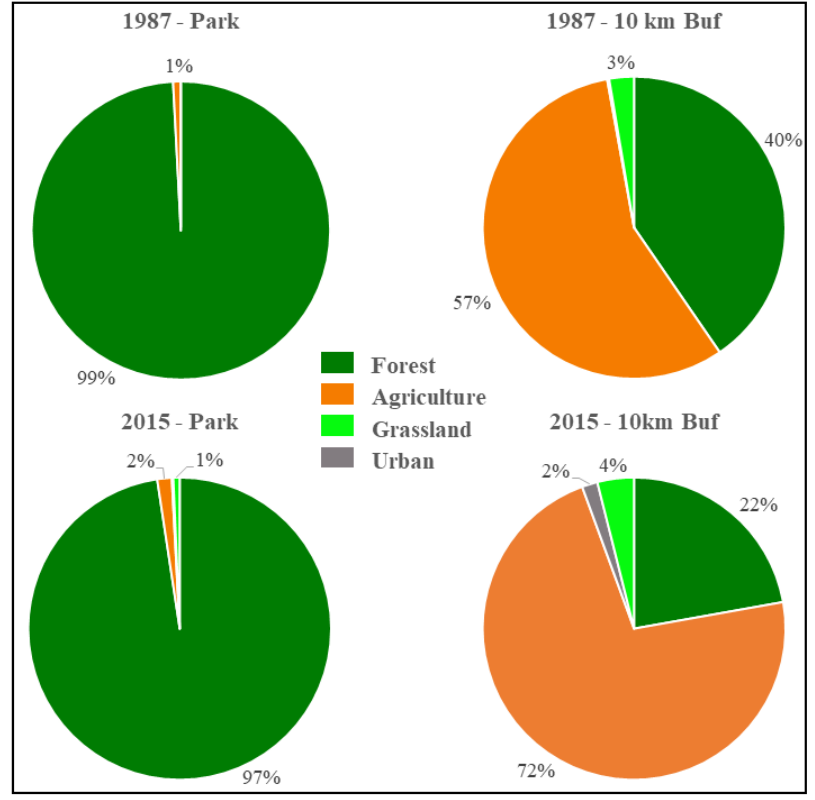
Figure A1. The trend of land cover change in Rwenzori Park and a 10 km buffer zone using Landsat images from 1987 and 2015.